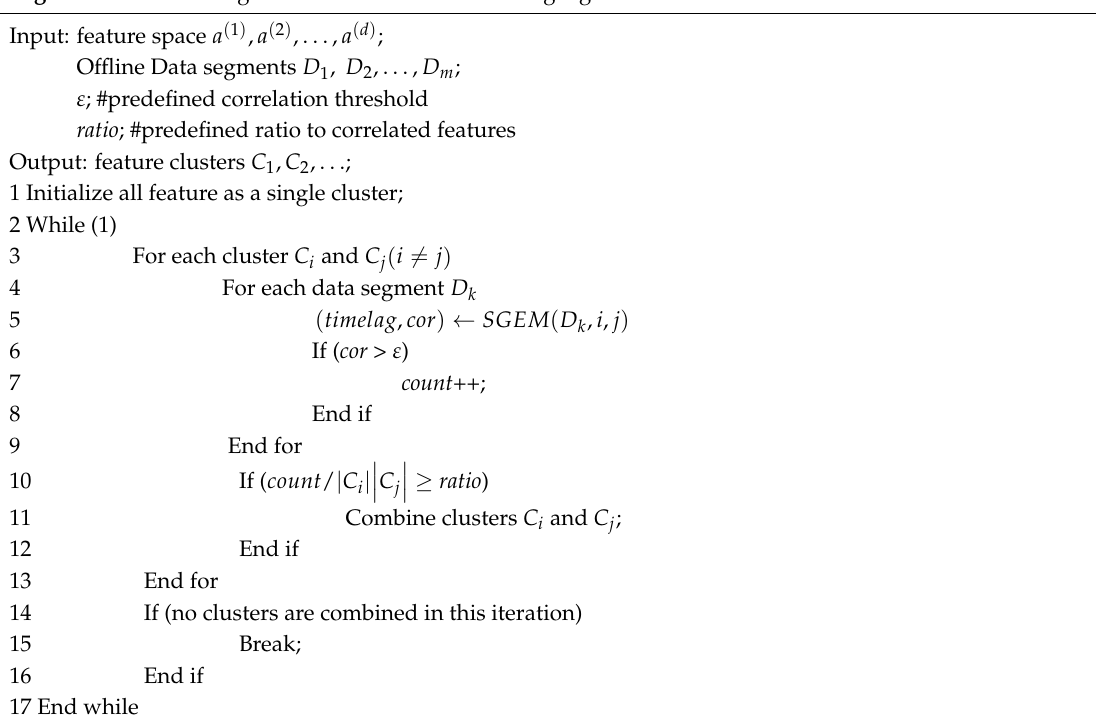
Algorithm 2. Curve alignment based feature clustering